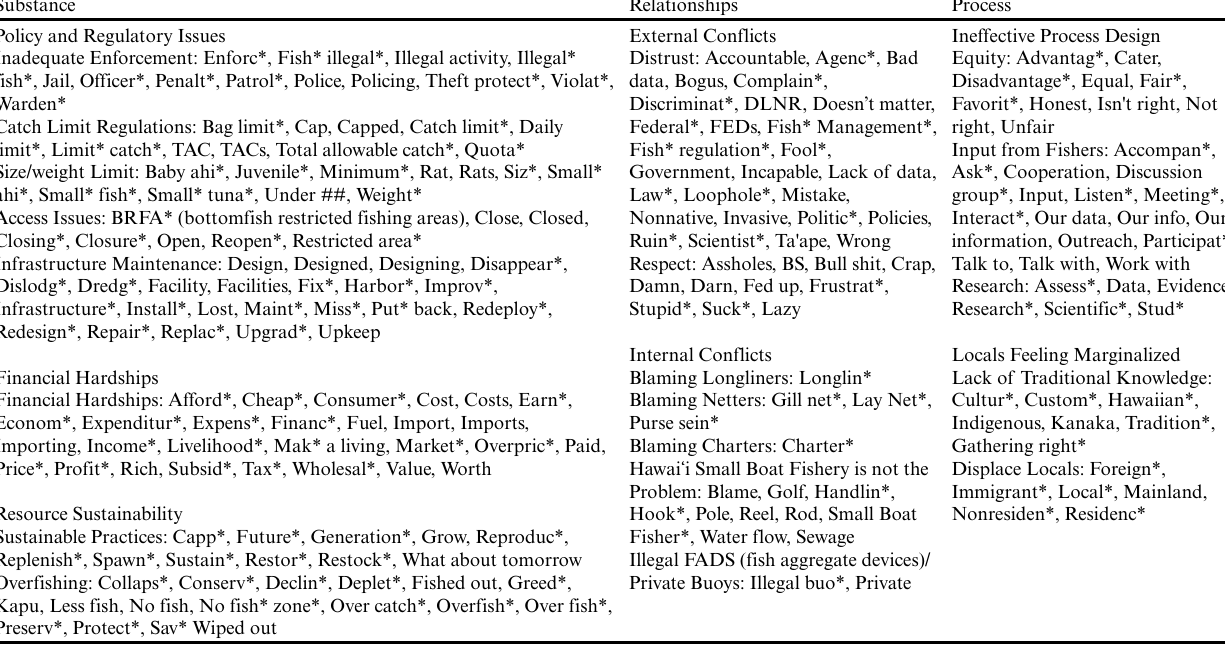
Table 2 . Data dictionary for the Hawai ʻ i small boat fishery. Words containing the * symbol include all letters following that root word. Substance Relationships